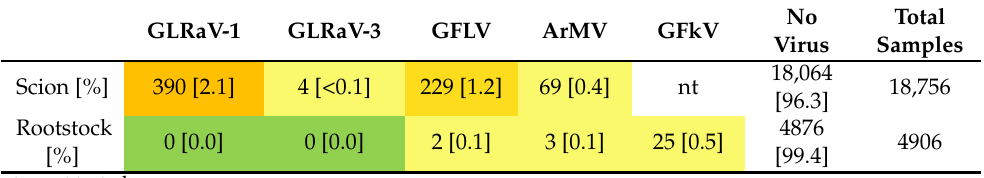
Table 3. Rootstock planting material has fewer virus infections than scion material. Listed are the results of ELISA tests on scion and rootstock planting material between 2009 and 2020. The table shows the amount of positive tested samples for each virus and the percentage relative to the total number of pooled samples of the year in question (square brackets). Grapevine fleck virus (GFkV) was only tested in rootstock samples. Individual viruses are color coded depending on their incidences: 0.0% (green); 0.1–0.9% (pale yellow); 1.0–1.9% (yellow); 2.0–4.9% (dark yellow); 5.0–9.9% (orange); over 10.0% (dark orange).